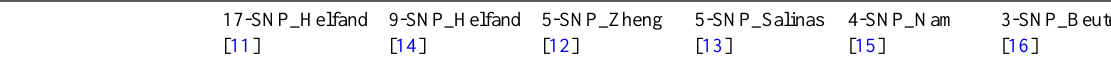
Table 6. Examples of cumulative risk prediction models for prostate cancer.